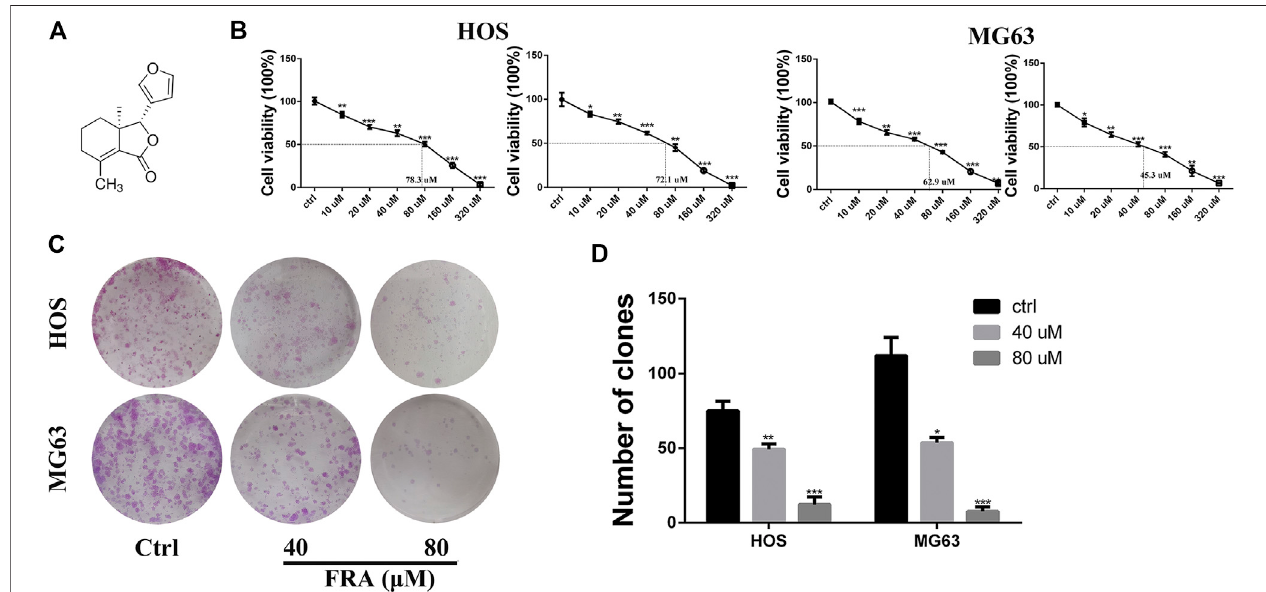
FIGURE 1 | FRA inhibited osteosarcoma cell proliferation in vitro . (A) Chemical structure of fraxinellone (FRA). (B) Human osteosarcoma cell lines (HOS & MG63) were treated with different concentrations of FRA for 24 and 48 h before CCK8 assays were utilized. (C) Compared with control group, FRA signi fi cantly suppresses colony formation in HOS and MG63 cell lines. (D) Number of clones in plates were analyzed. These data were detected by a microplate reader and a microscope, respectively. * p < 0.05, ** p < 0.01, and *** p < 0.001 compared with the